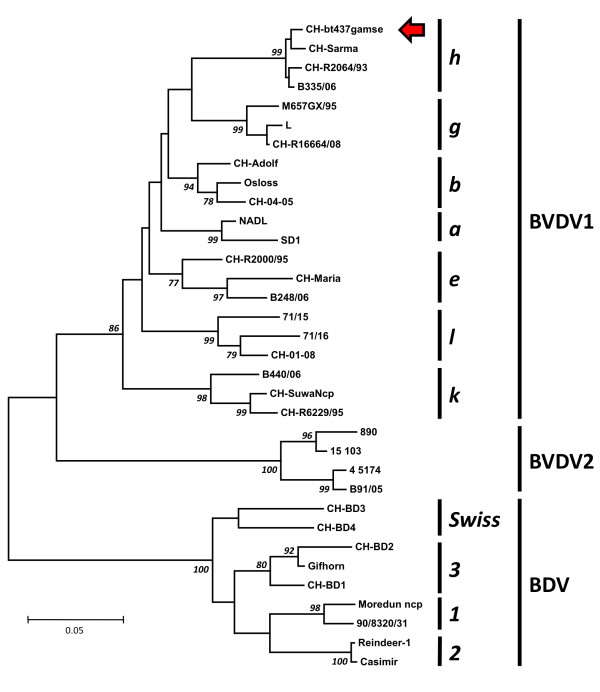
Unrooted phylogenetic tree based on the 5’UTR (229 positions) of bovine viral diarrhea virus (BVDV). The chamois virus sequence (red arrow) is shown in the context of other pestiviral isolates from cattle and small ruminants in Switzerland to date. Swiss isolates are labeled with CH- preceding the name. Additional sequences were obtained from GenBank. BVDV1 subgenotype a, b, e, g, h, k and l, BVDV2 and BDV 1, 2, 3 and Swiss are shown. From BVDV1 subgenotype g and l, only one isolate each has been found in Switzerland, whereas subgenotypes h, e, k and b are common. The BDV Swiss genotype has been found only in Switzerland so far. Branch numbers (italics) indicate the percentage of 2000 bootstrap replicates
[4]. Only bootstrap values over 75 are shown. Branch lengths are proportional to genetic distances, and the bar shown indicates 0.05 substitutions per site.